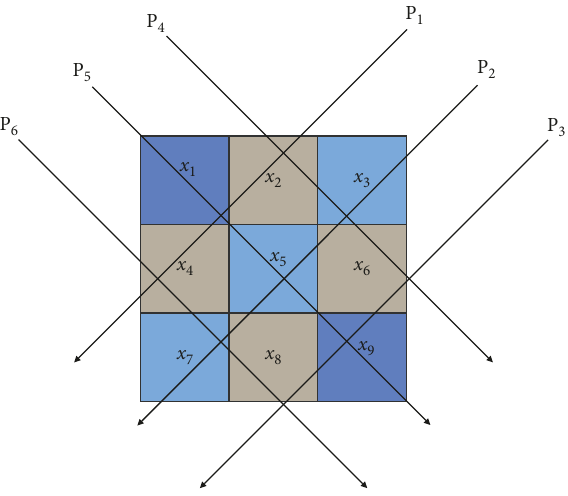
Figure 4: Schematic diagram of discretized image